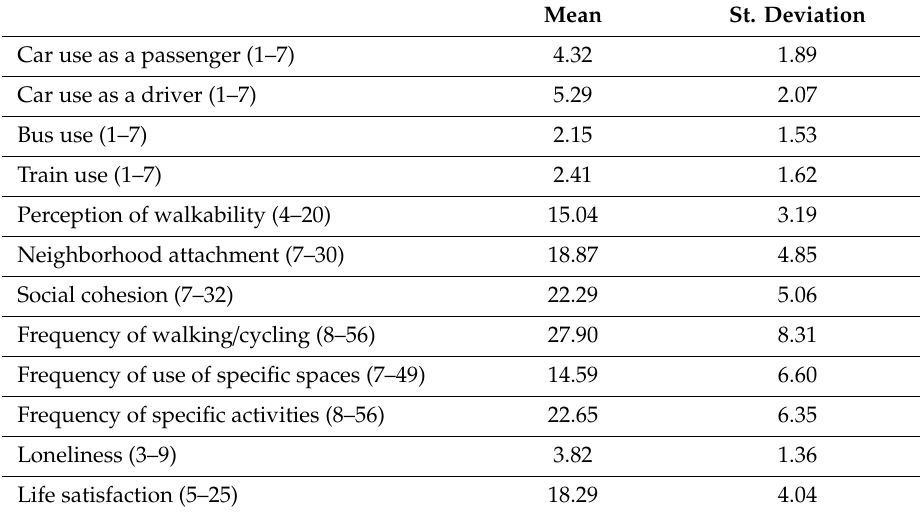
Table 3. Social neighborhood characteristics, mobility, loneliness, and life satisfaction (N = 200).